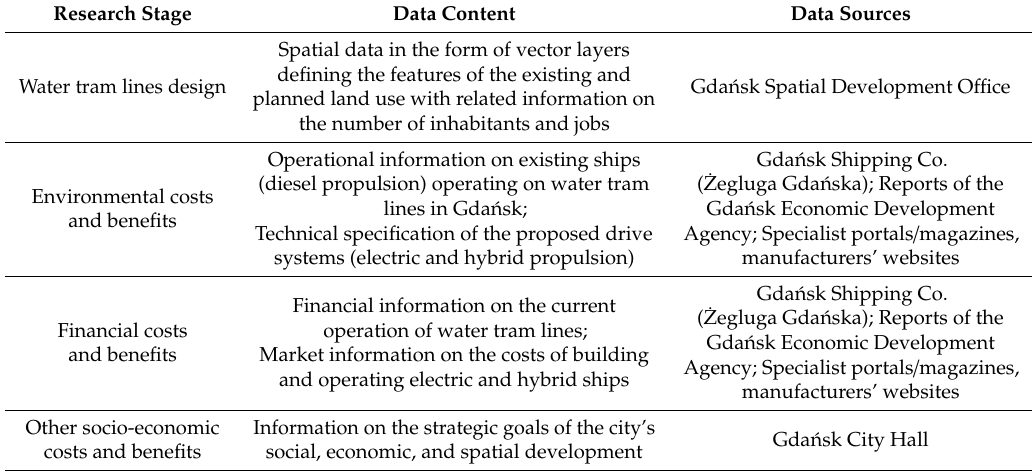
Table 1. The content and sources of data used at each stage of the research procedure.